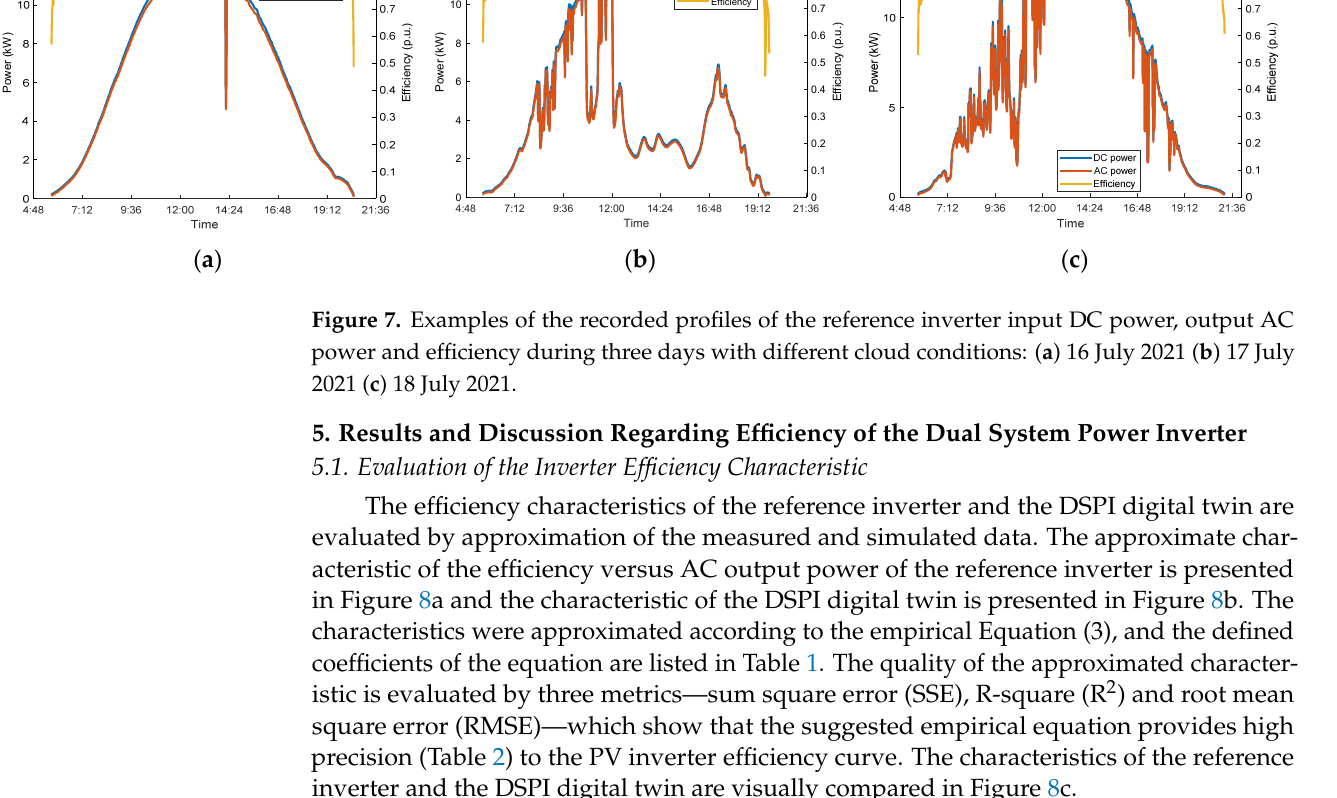
data sampling step of the measuring system was 20 ms, the data of DC currents and volt-